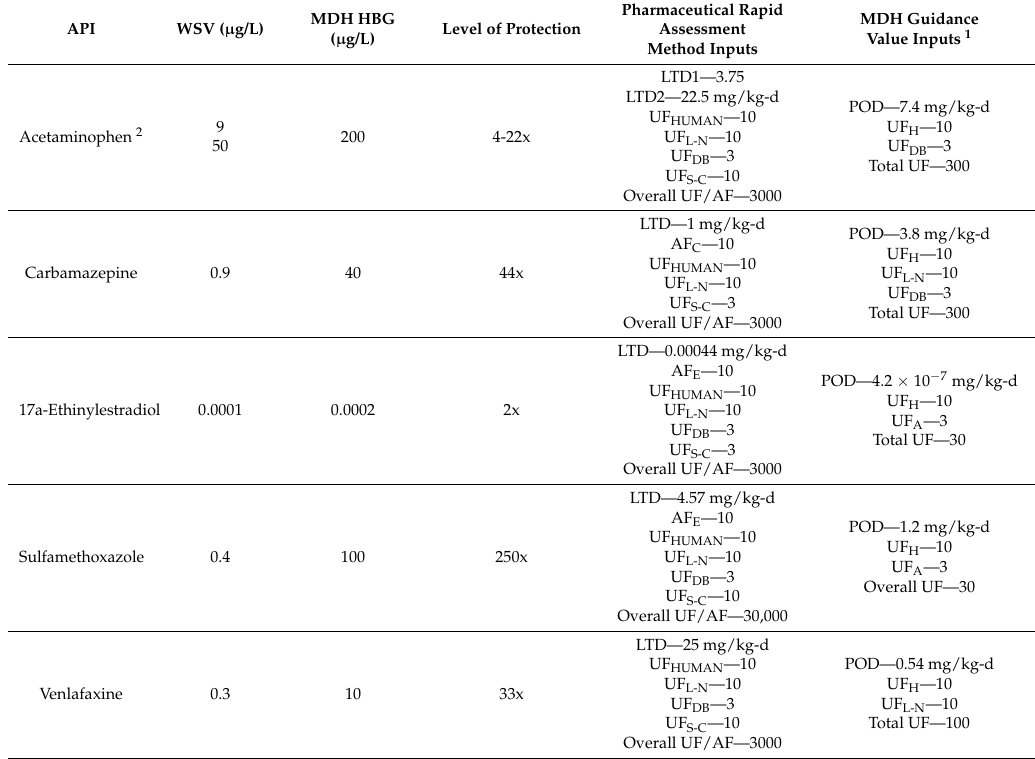
Table 4. Comparison of Inputs and Values for the Pharmaceutical Rapid Assessment Method for Deriving WSVs and MDH established traditional method for deriving Health-Based Guidance Values